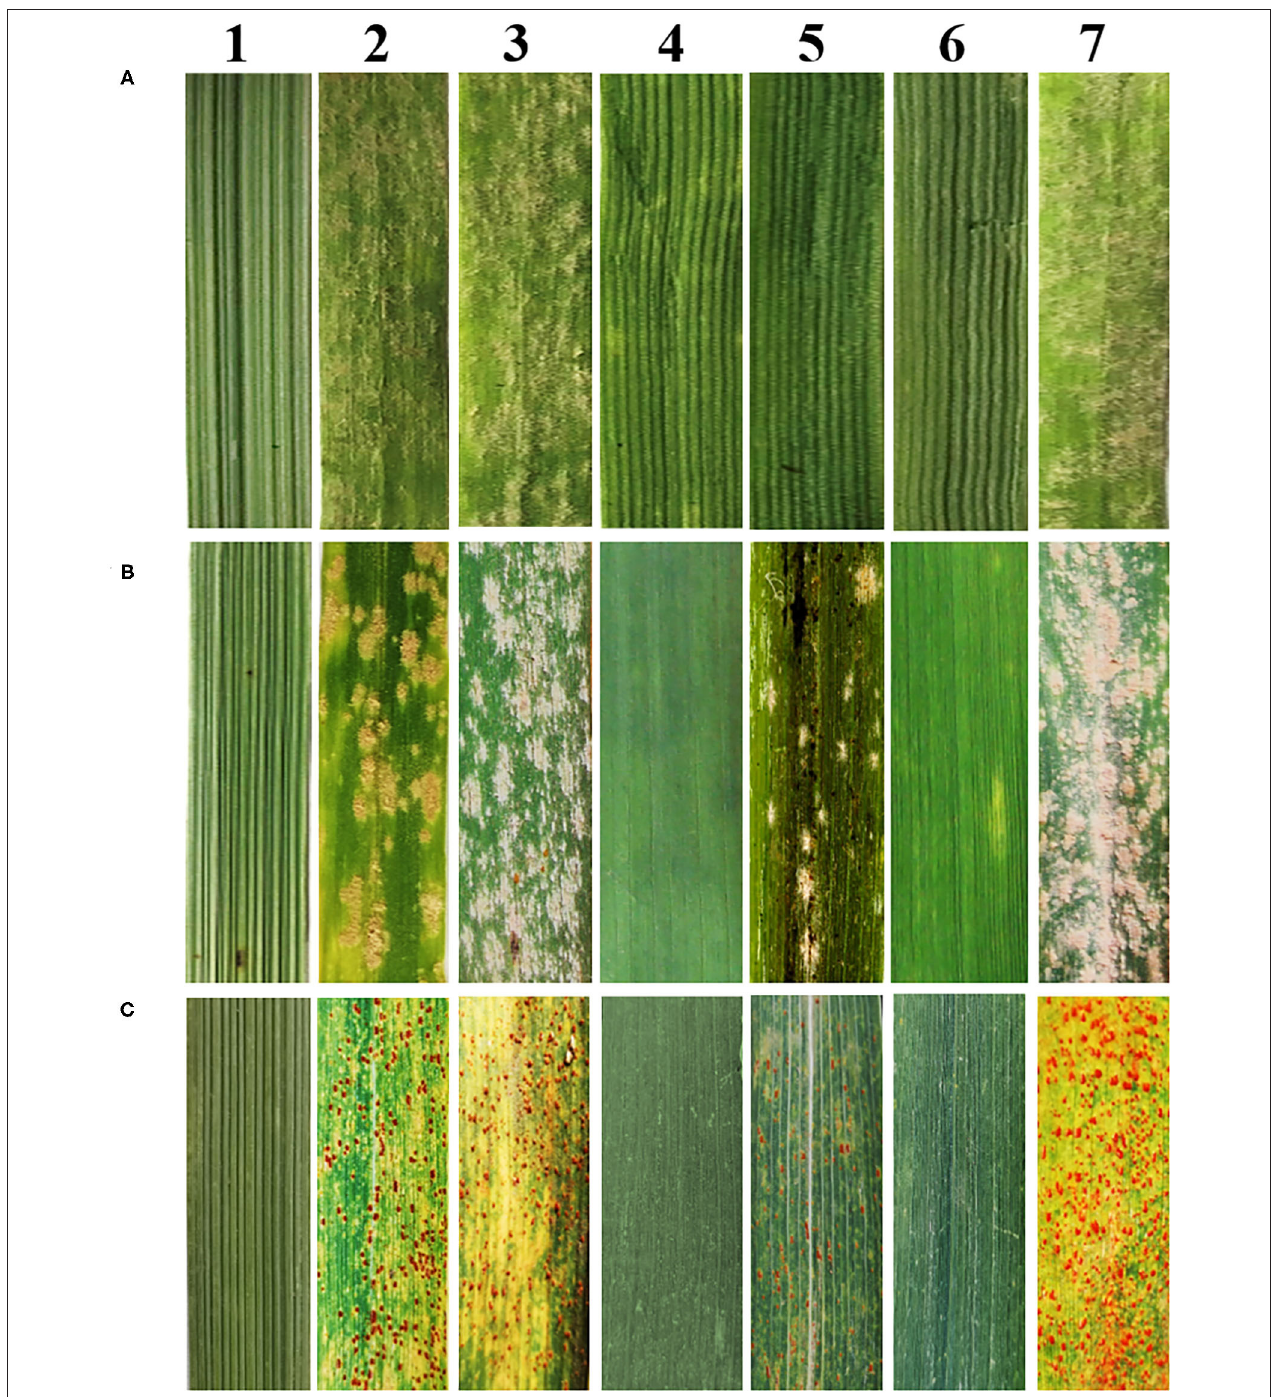
FIGURE 1 | Reactions to powdery mildew and leaf rust. (A) Reactions to powdery mildew at the seedling stage. (B) Reactions to powdery mildew at the adult stage. (C) Reactions to leaf rust at the adult stage. 1–7 refers to Th. ponticum , YN15, SNF63, SNTE20, JM22, SN19647 and HXH,